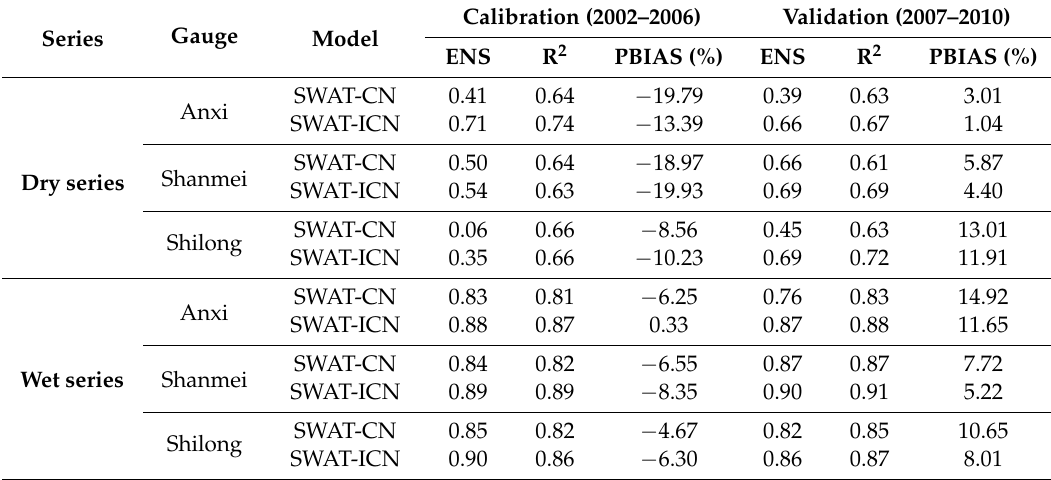
Table 4. Seasonal performance measures of SWAT-ICN and SWAT-CN in Anxi, Shanmei, and Shilong subbasins for calibration and validation